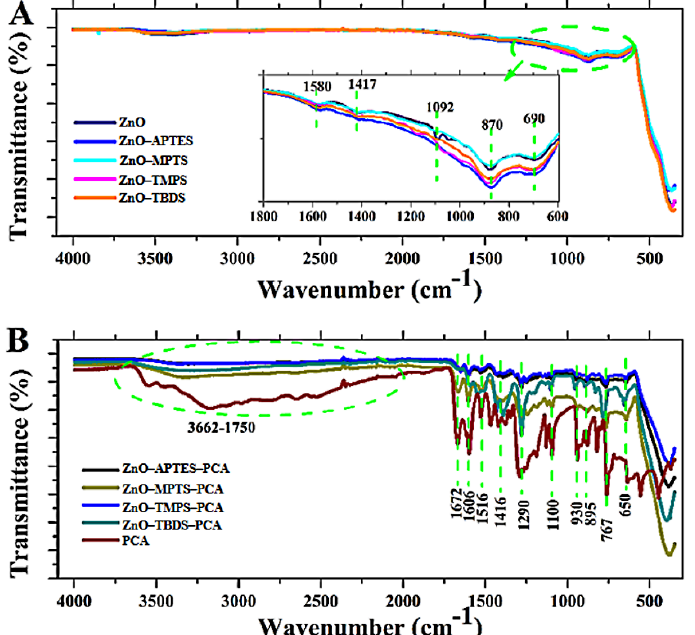
Figure 5. The spectra of ZnO NPs, modified ZnO NPs, and nanoformulations by Fourier-transform infrared spectroscopy. ( A ) ZnO NPs before and after surface modification. ( B ) Nanoformulations consisting of PCA and free PCA. In panel ( A ), the dotted green circle and lines show the changes following surface modifications with various silane groups compared to ZnO NPs. In panel ( B ), the dotted green circle and lines represent the detected new peaks in nanoformulations corresponding to free PCA.